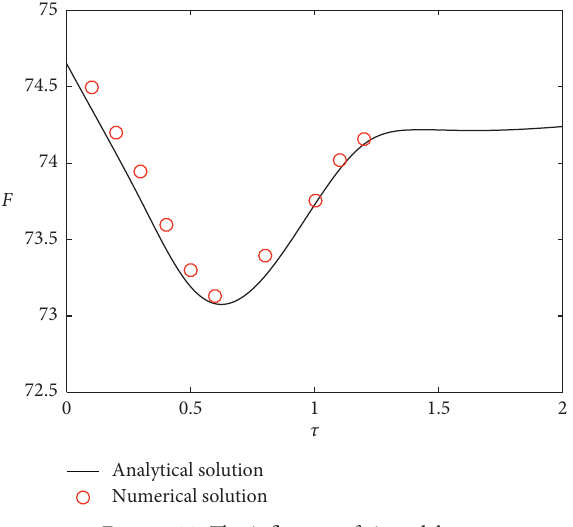
Figure 11: The influence of time delay.